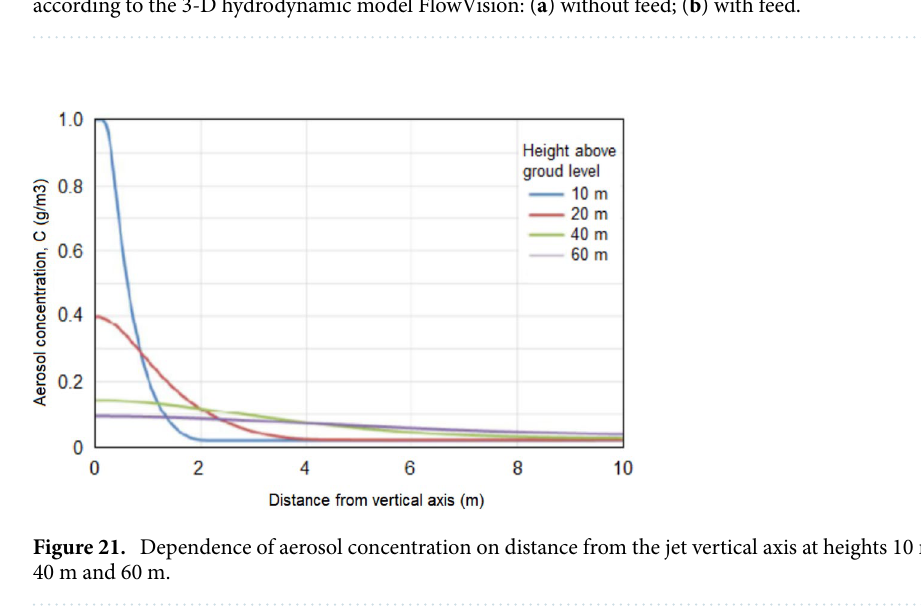
Figure 20. Vertical section of air-aerosol motion in the jet and its surroundings in a windless atmosphere according to the 3-D hydrodynamic model FlowVision: ( a ) without feed; ( b ) with feed.